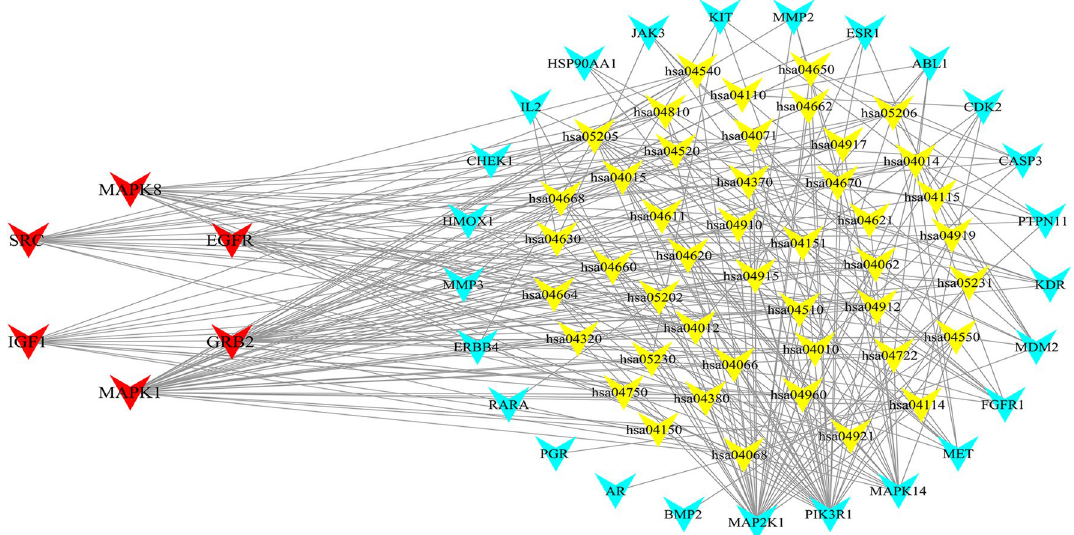
Figure 7. The Target-pathway network, constructed in Cytoscape3.7.2 (https ://cytos cape.org/), was built by the candidate targets and a pathway if the pathway was lighted at the target. (Yellow nodes represent signaling pathway from enrichment analysis. Blue nodes represent the candidate targets in fucosterol. Red nodes represent the hub genes screened by PPI